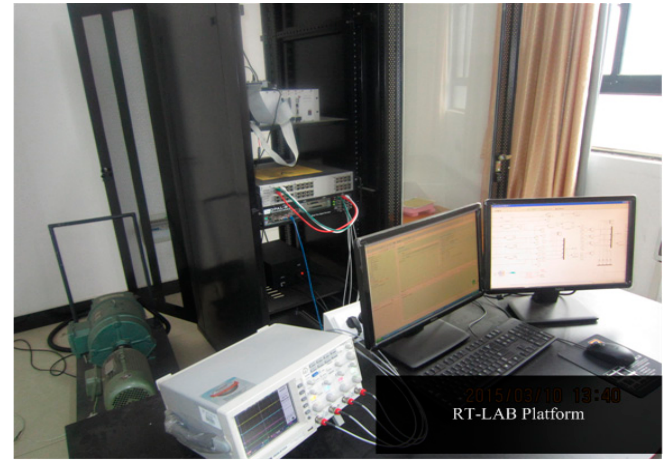
Figure 16. Photo of the RT-LAB experimental setup.